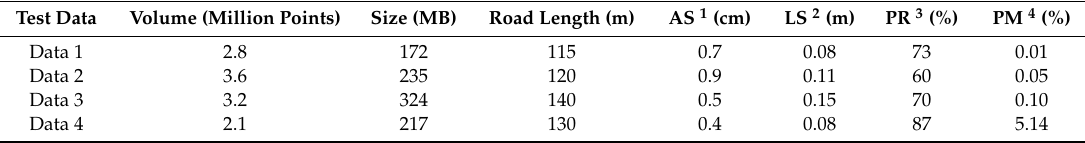
Table 1. Test data environment. Table 2. Test data